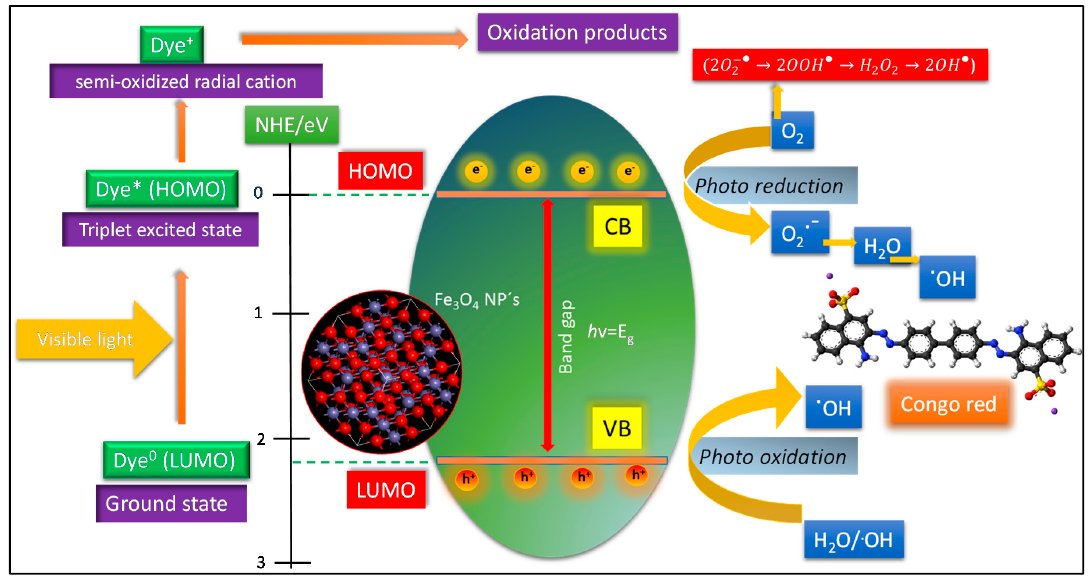
Figure 8. Schematic representation of dye photodegradation process.